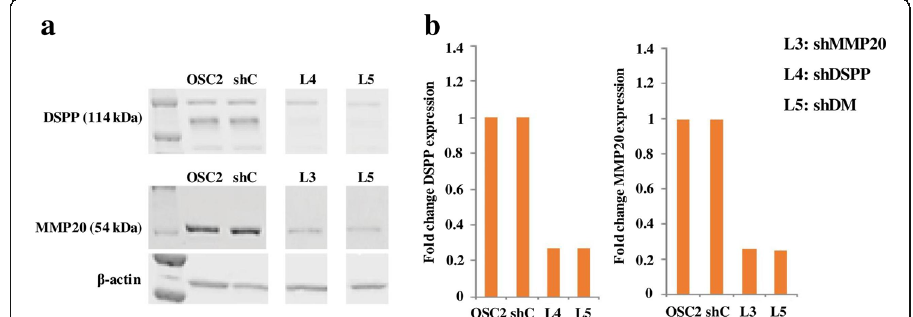
Fig. 1 Lentiviral mediated knockdown of DSPP (shDSPP), MMP20 (shMMP20) and DSPP+MMP20 (shDM) in OSC2 cells, and generation of stable DSPP / MMP-20 / DSPP+MMP20 silenced OSC2 cell lines . Protein expression levels of DSPP and MMP20 ( a ) are presented as relative fold change levels in knockdowns (shDSPP, shMMP20 and shDM) compared to scramble-control (shC) ( b ). Among the different stable lines selected, L4 exhibited the maximum knockdown (73%) for DSPP-silencing, L3 for MMP20 (74%) and L5 for DSPP+MMP20 silencing (73 and 75% for DSPP and MMP20, respectively), as compared to shC at the protein level